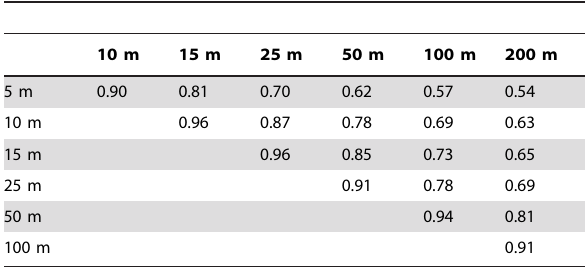
Table 3. Correlation of the CASI bands with the PCA components.